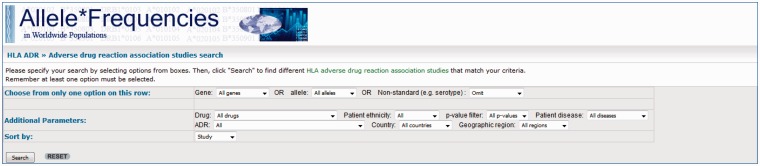
Screenshot of the HLA-ADR query page. Users can query the database via the use of
filters. They may choose to see associations for genes/alleles, drugs, patient
ethnicity, level of significance (P values) and the country/region
where the study was conducted.